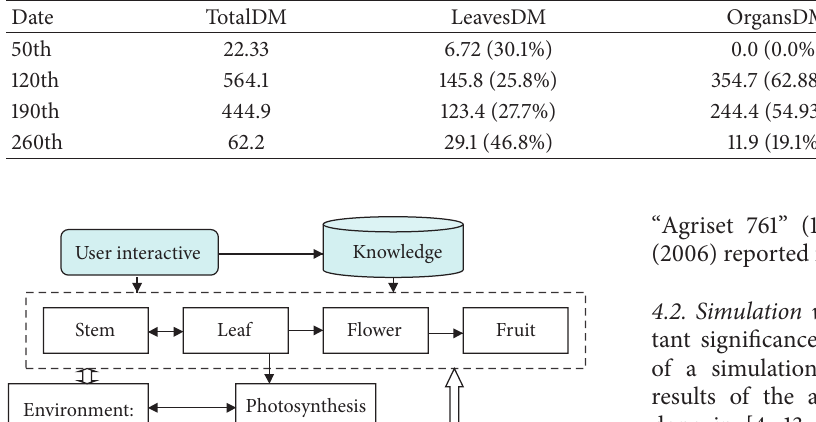
Table 2: Results of simulating the growing of tomato planted in different dates.